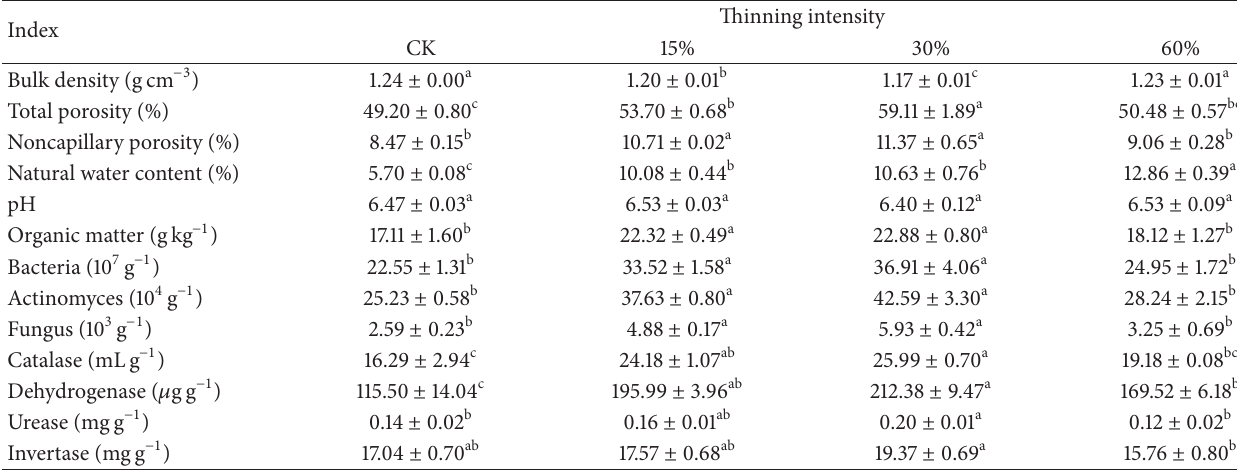
Table 3: Characteristics of forest soil properties.